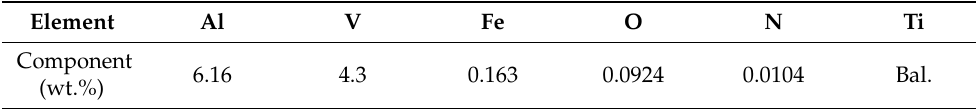
Table 3. Process parameters of 3D printing.